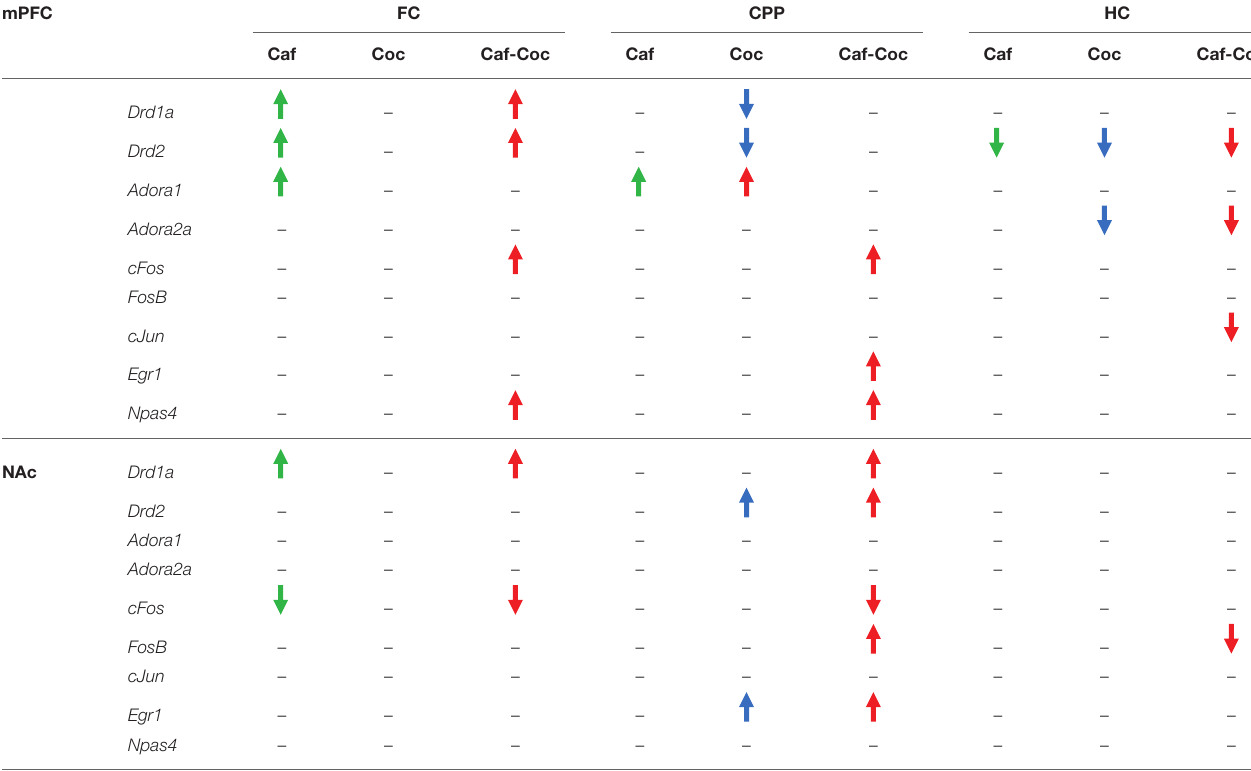
TABLE 2 | Gene expression change for all experimental conditions: FC (first conditioning CPP session), CPP (CPP test session) or HC (injections in home cage).